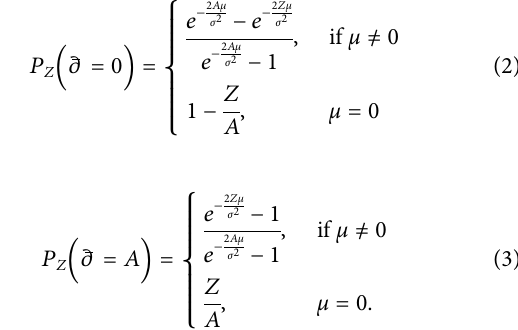
(cid:129) The increment, W − W t + s s , has the distribution of the standard normal random variable, N (0, t ) ( this latter of N (0, t )) .